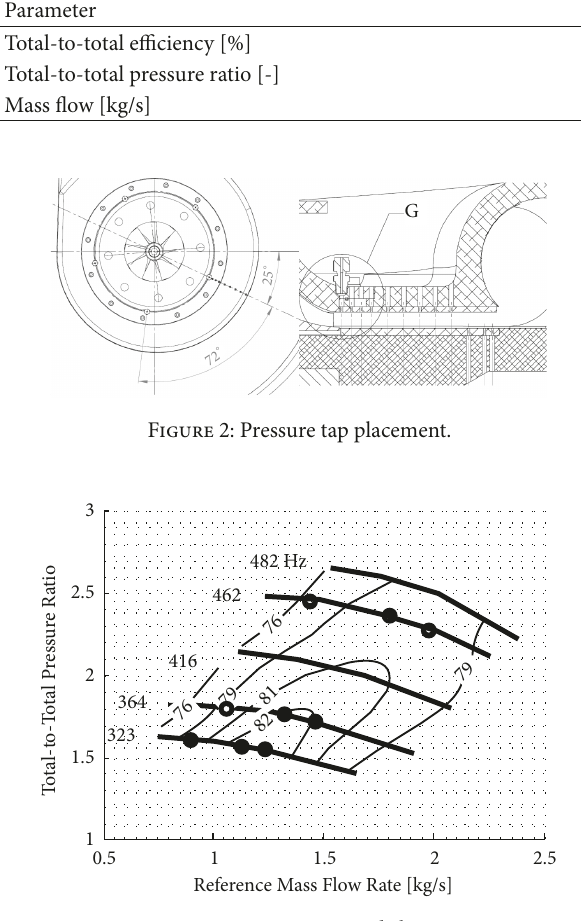
Figure 3: Compressor operating map and the operating points at which the static pressures were measured.